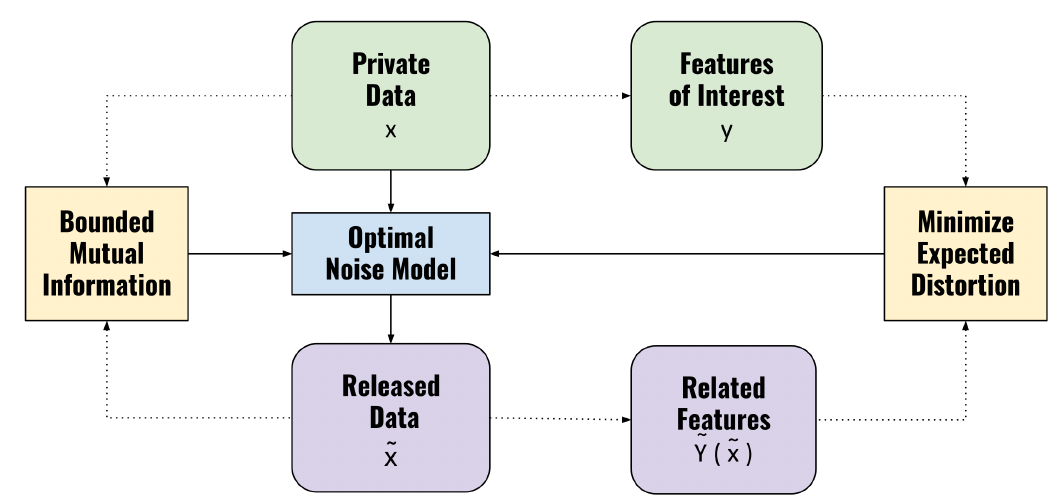
Figure 9. Design of optimal noise model for tackling the tradeoff between privacy-leakage (in terms of bounded mutual information between private data and perturbed released data) and feature distortion (loss of accuracy); for details see Reference